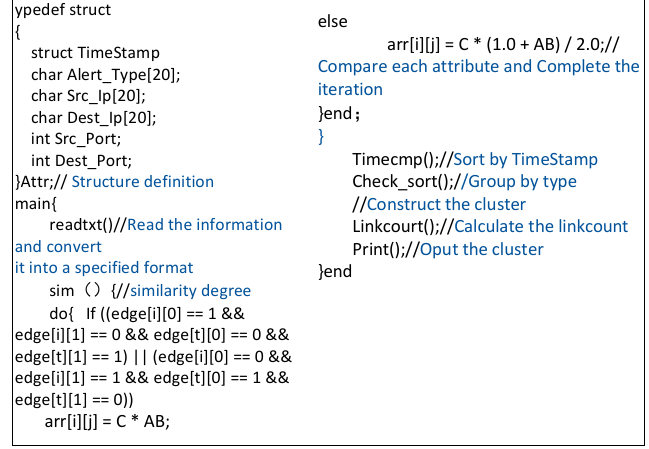
Figure 6. The pseudo-code of the Alert Instance Correlation Module (AICM) module.